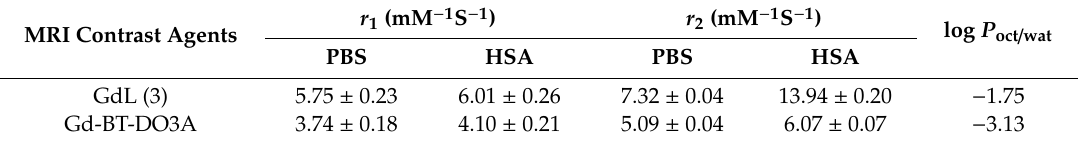
Table 1. Relaxivity and octanol–water partition coe ffi cients of GdL (3) and Gd-BT-DO3A in PBS and HSA using a 3.0 T MR scanner at 294